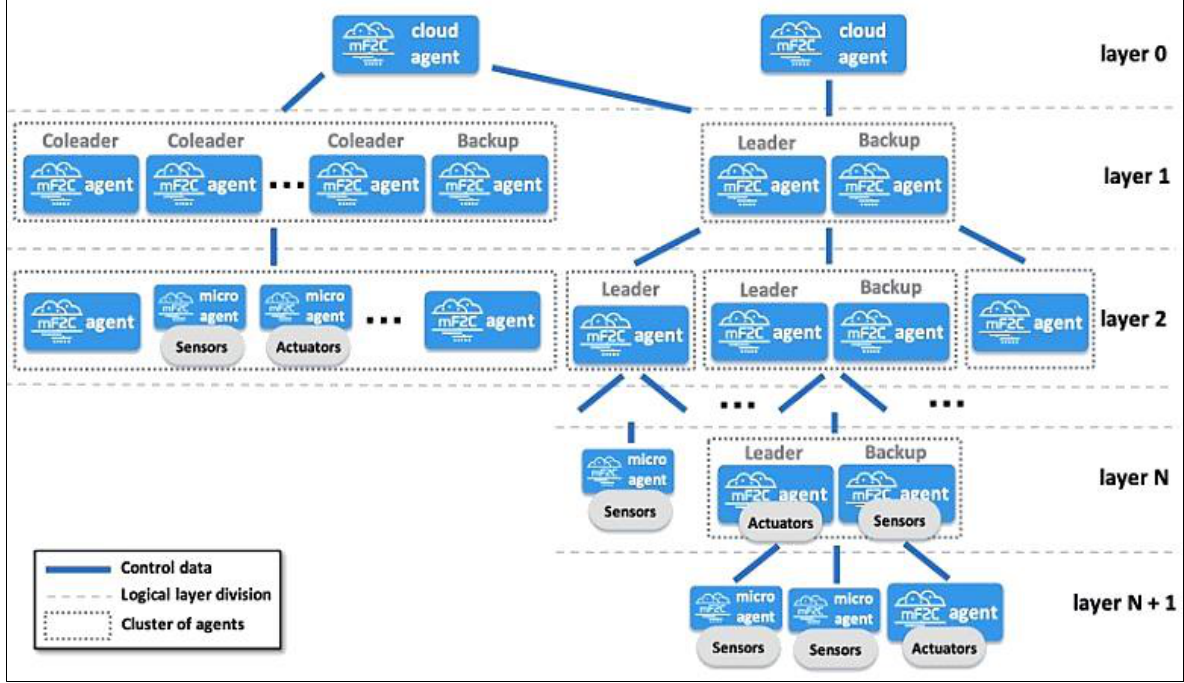
Figure 2. mF2C hierarchical